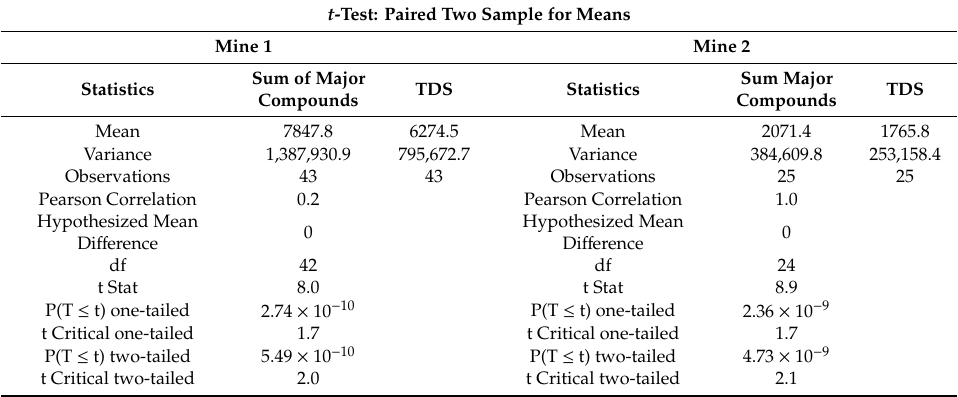
Table A2. The t -test results for comparing the sum of major compounds and TDS. t -Test: Paired Two Sample for